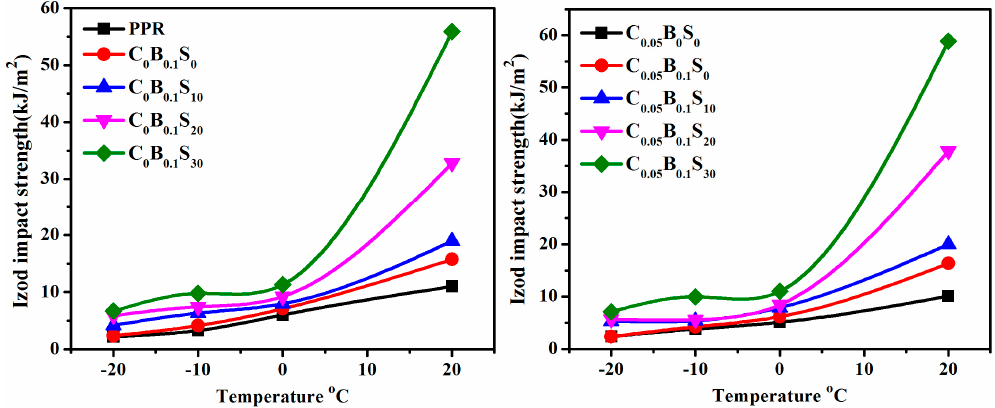
Figure 2. Izod impact strength of PPR and its blend at various temperature.